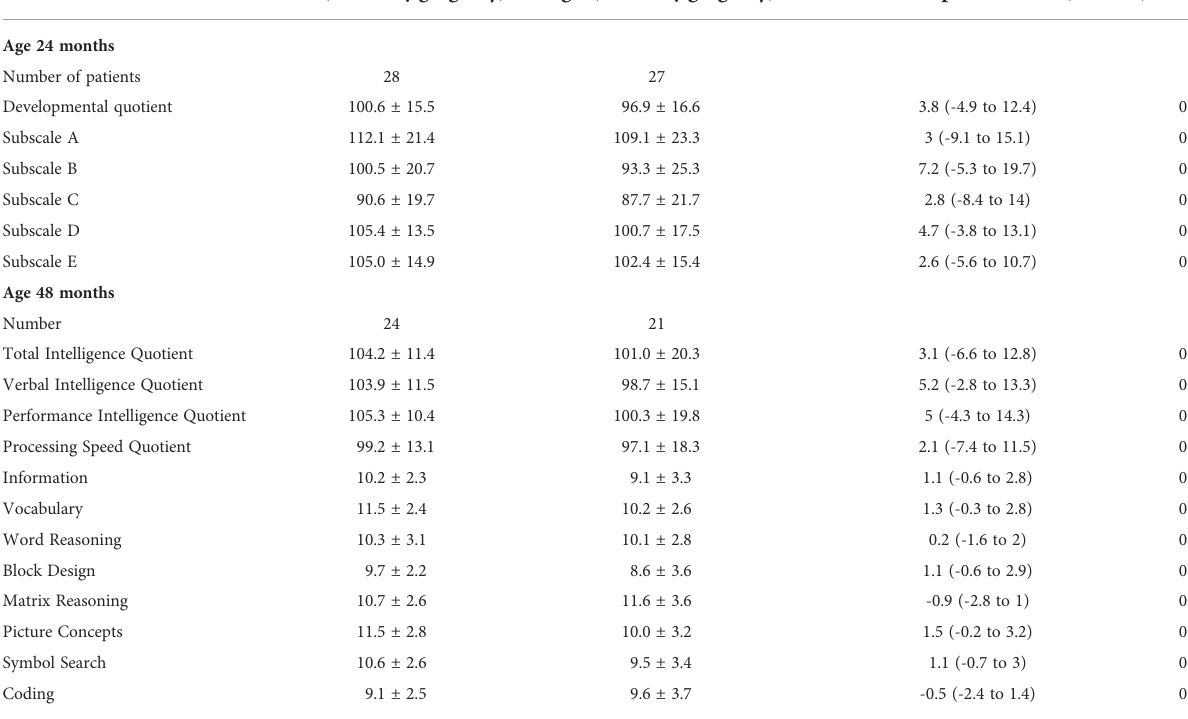
TABLE 2 Developmental Quotients and subscale scores at 24 months of age and Intelligence Quotients and subtest scores at 48 months of age in the two groups of patients with different initial treatment